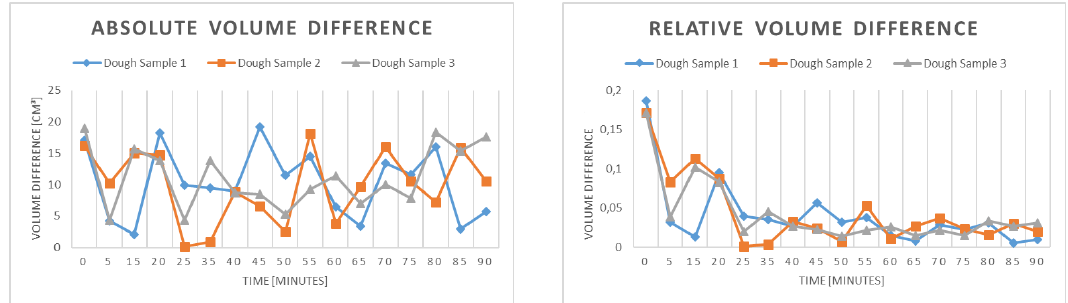
Figure 12. Volume Difference: absolute (left) and relative (right).